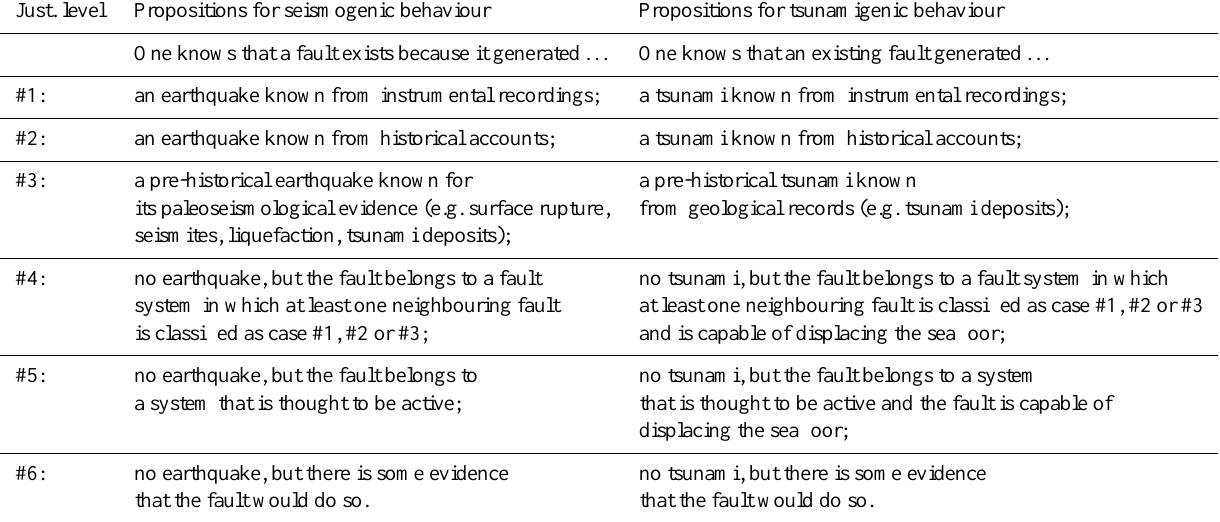
Table 2. Classification scheme for the justification levels of seismogenic (left) and tsunamigenic (right) behaviour of fault sources. Just. level Propositions for seismogenic behaviour Propositions for tsunamigenic